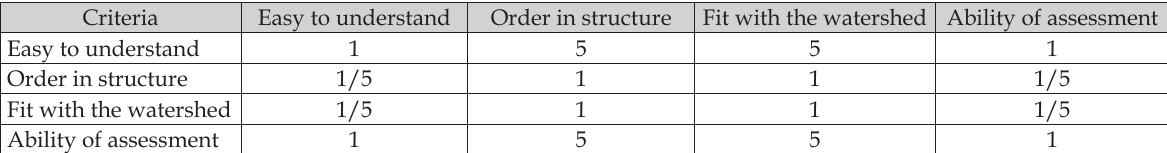
Table 3. Paired comparison matrix for the criteria used to evaluate the efficiency of geosites evaluation models.